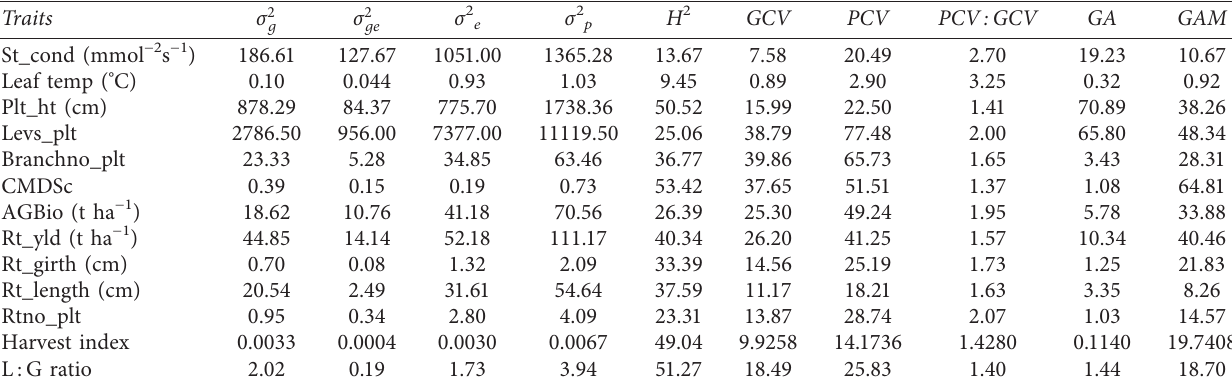
Table 7: Estimates of variance components, heritability, and phenotypic and genotypic coefficients of variation for nine traits in 20 cassava genotypes across six